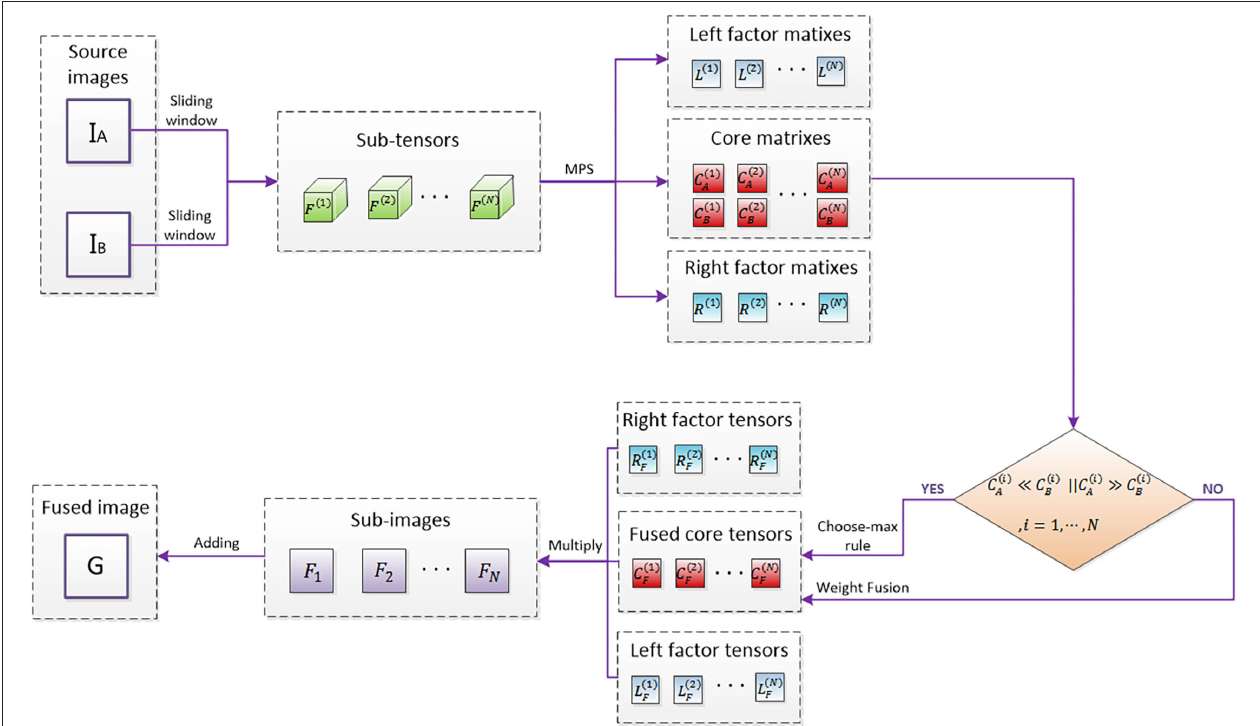
FIGURE 4 | Fusion flowchart based on